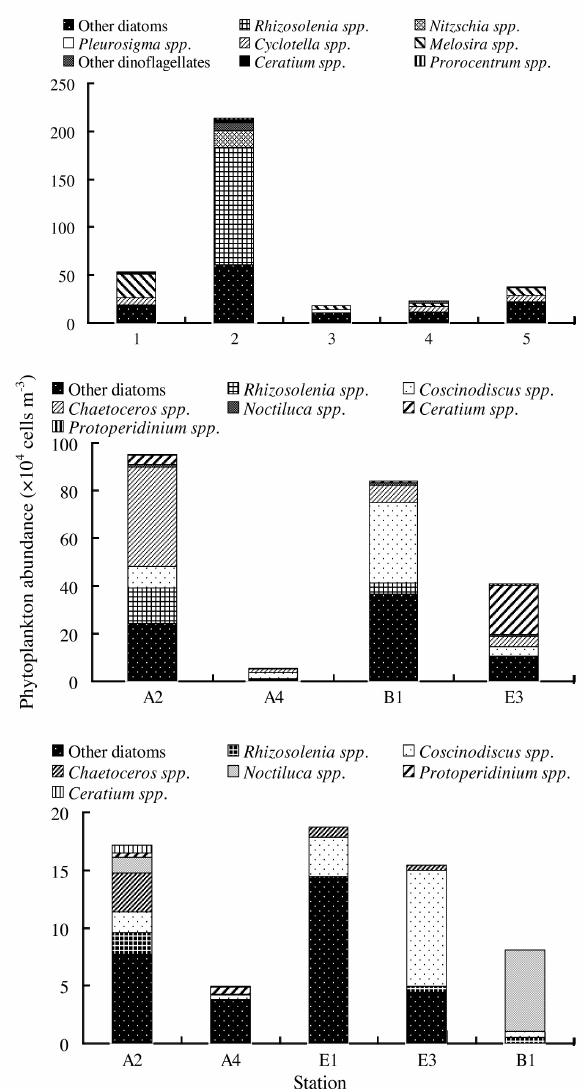
F IG 2. – Percentage composition of different phytoplankton groups during three cruises (From top: June, investigated with water samples by Niskin sampler; October, with net hauls; May, with net hauls)